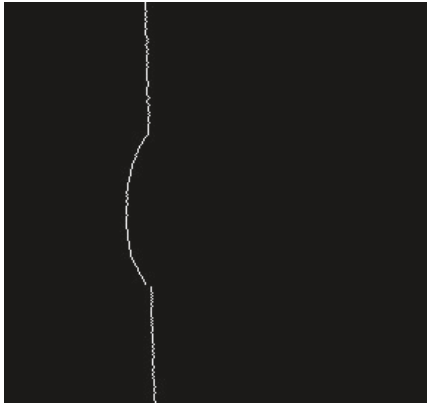
Figure 4: Remove the interference after the laser